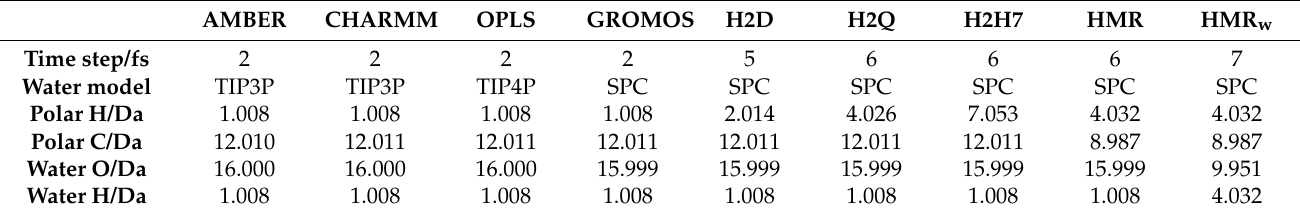
Table 1. Summary of the time steps employed in each MD simulation, as well as the corresponding masses of the polar atoms in the system. Note that there are no polar hydrogens in GROMOS POPC lipids, so the only affected atoms belong to the